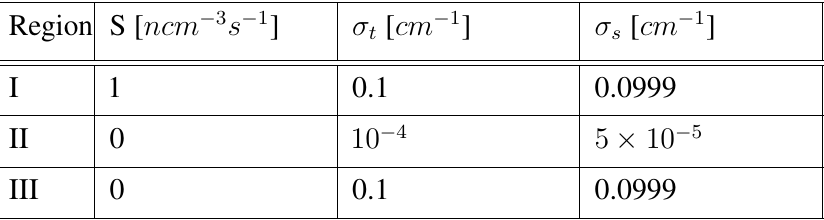
Table 2: ANN results for the Benchmark problem [6] with c = 0 . 999